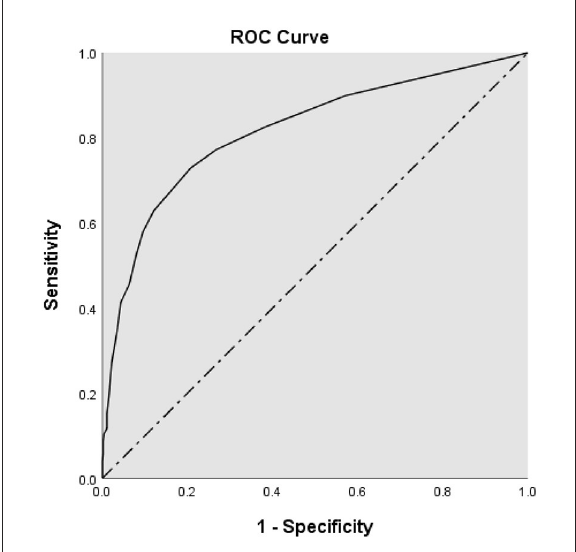
FIGURE1 Receiver operating characteristic curve (ROC) analysis for the suicide screening questionnaire-observer rating (SSQ-OR).